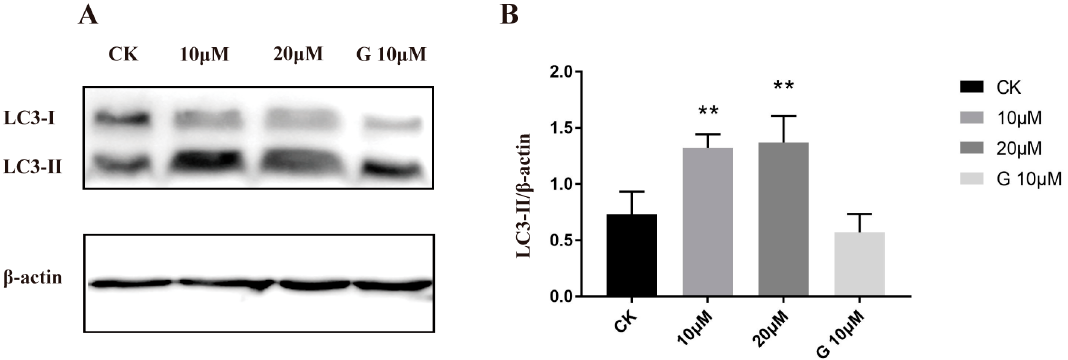
Figure 7. The effects of 5i on the autophagy-related protein LC3. ( A ) Western blot analysis of LC3-I and LC3-II of A549 cells treated with 5i (0, 10, and 20 µ M) for 48 h. Gefitinib with a concentration of 10 µ M was used as positive control (G-10 µ M). ( B ) The relative protein expression levels of LC3-I and LC3-II were quantified by normalization to β -actin. β -actin was used as a loading control. The values are expressed as mean SD from three individual experiments. ** Statistically extremely significant ( p < 0.01).